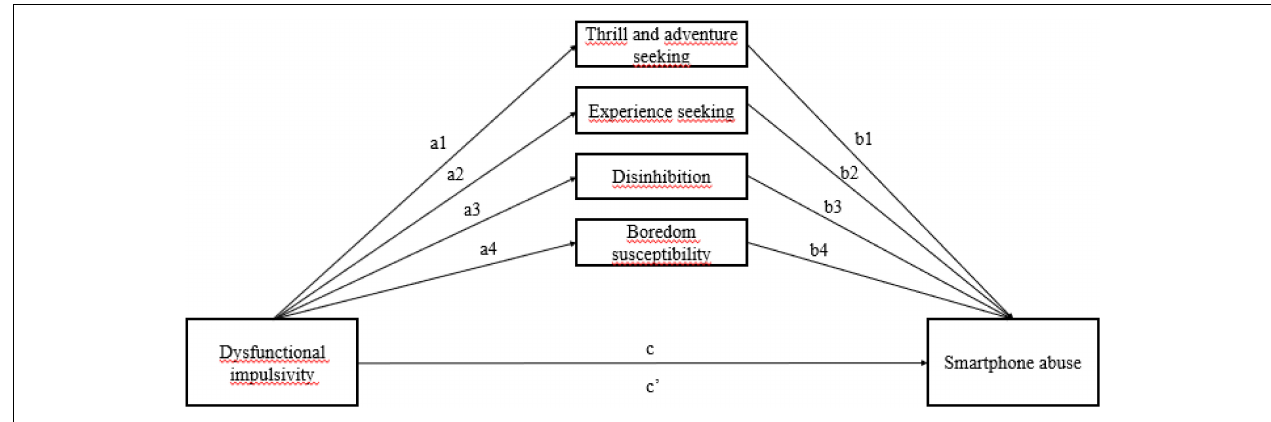
FIGURE 1 | Proposed model of the indirect effect of dysfunctional impulsivity on smartphone abuse through sensation seeking scales.